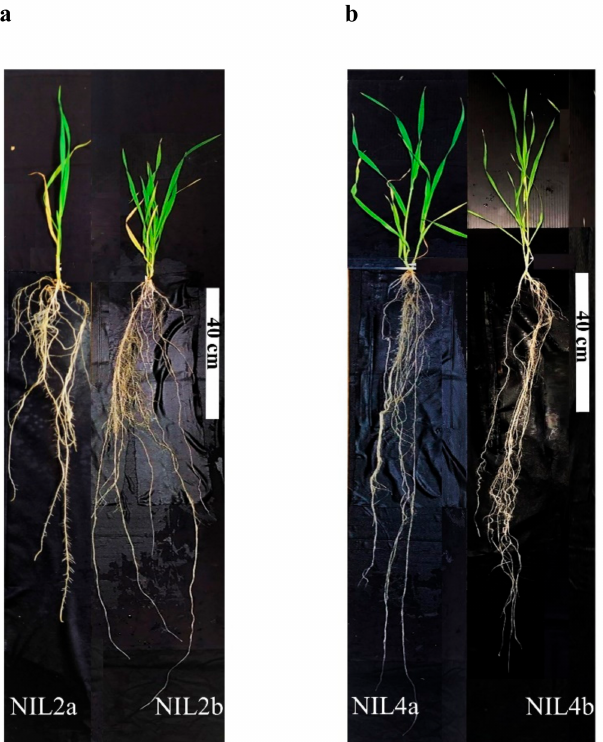
Figure 1. Contrasting rooting depth of two pairs of wheat near-isogenic lines (NILs) at 42 days after transplanting in a semi-hydroponic system in a glasshouse: ( a ) rooting depth of a NIL2a (72.8 cm) and a NIL2b (134.2 cm) plant, and ( b ) a NIL4a (134 cm) and a NIL4b (95.4 cm) plant. The white bar indicates a 40 cm